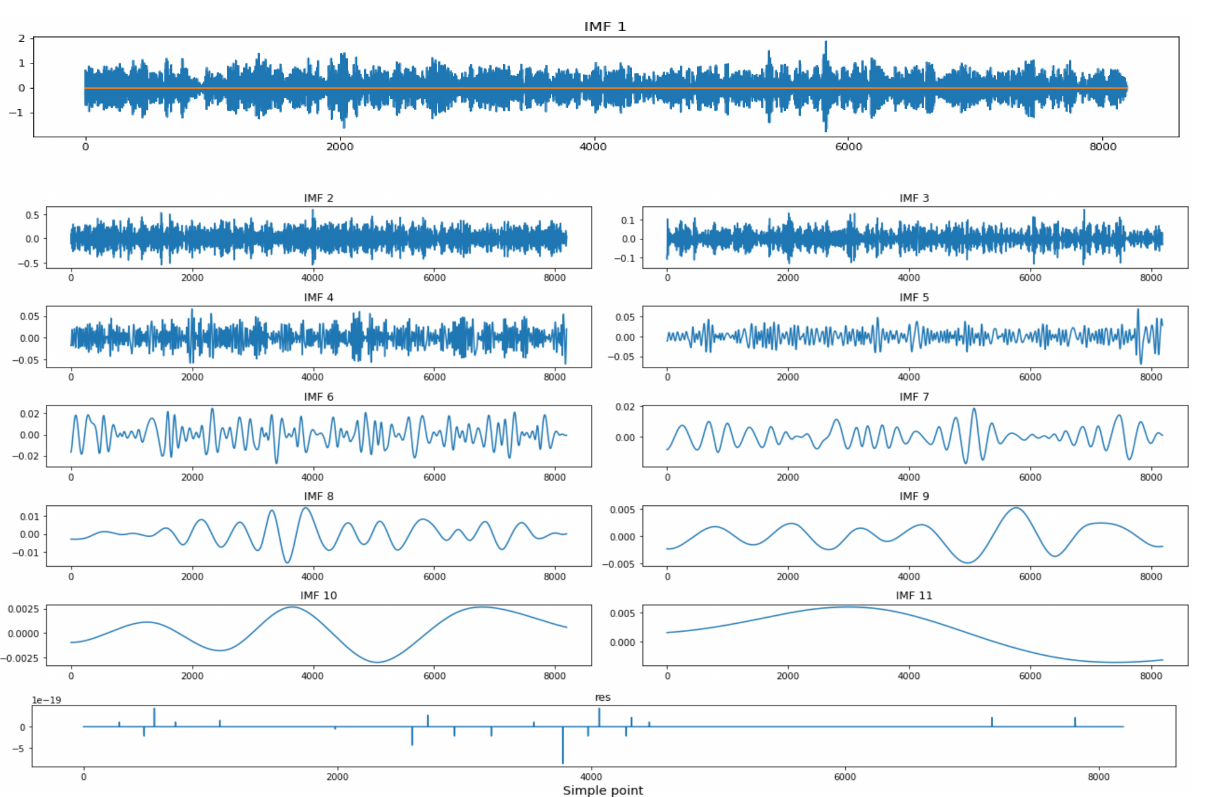
Figure 10. Results of decomposition for A_2 acceleration data